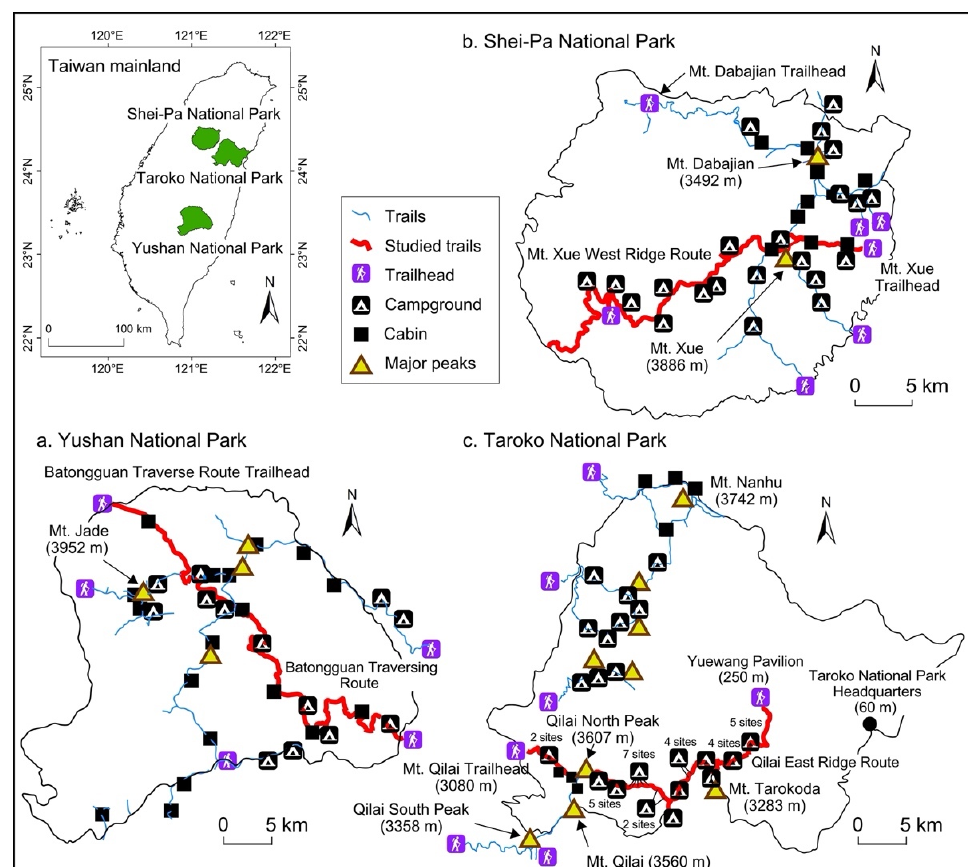
Figure 4. Maps of the Yushan ( a ), Shei-Pa ( b ), and Taroko ( c ) National Parks and the three studied trail sections (red bold lines) .